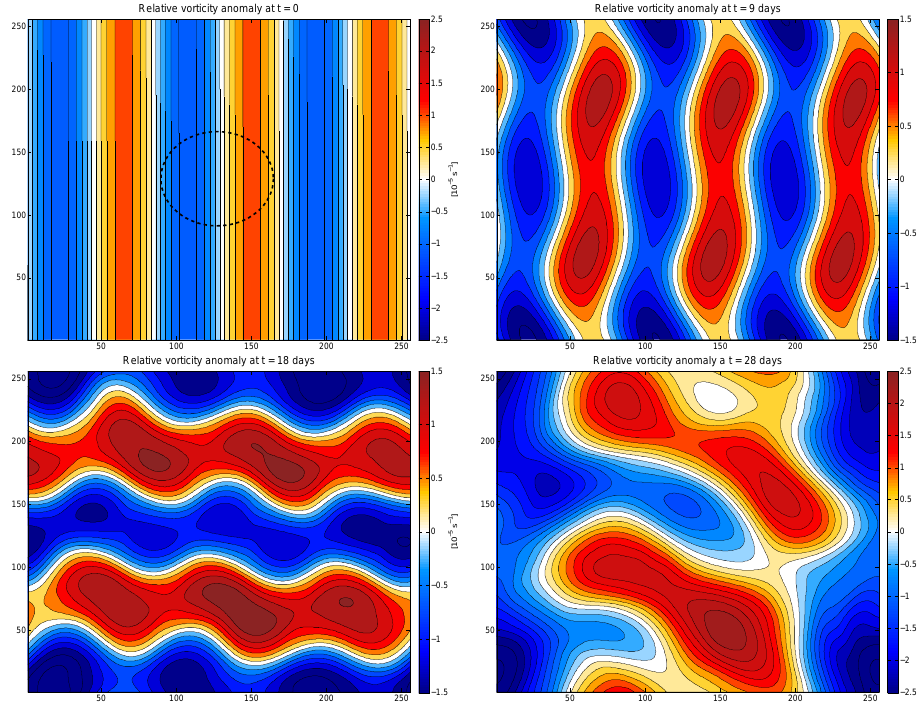
Figure 13. Evolution of the relative vorticity of a Rossby wave over a seamount, located at the middle of the map.